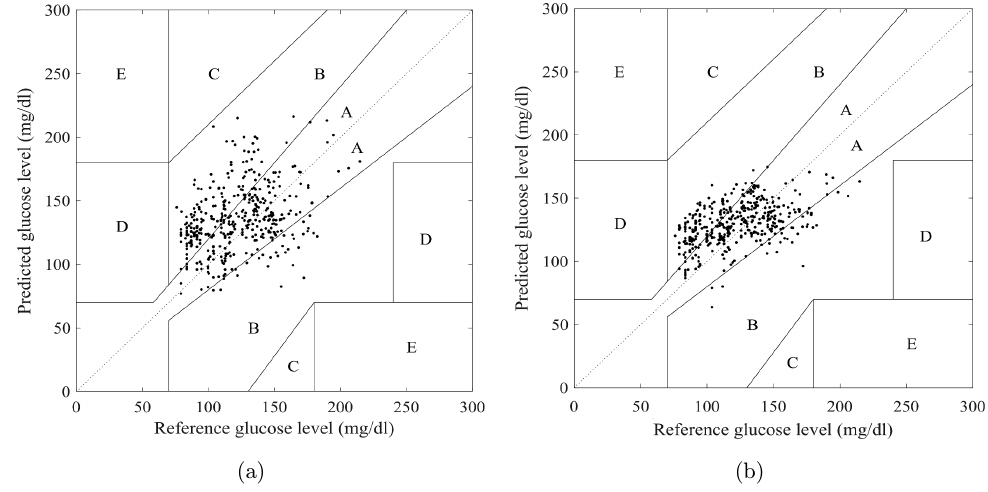
Fig. 8. Clark error grid of the unlabeled dataset for the estimation models: (a) without DA and (b) with